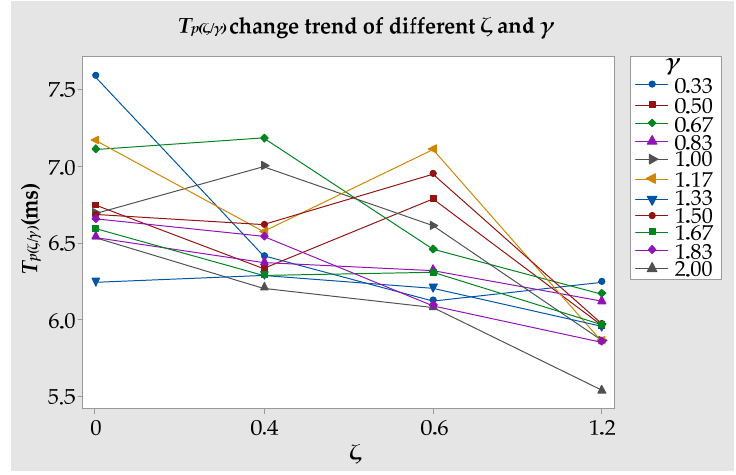
Figure 14. Bubble morphological change descriptions for types I–IV.